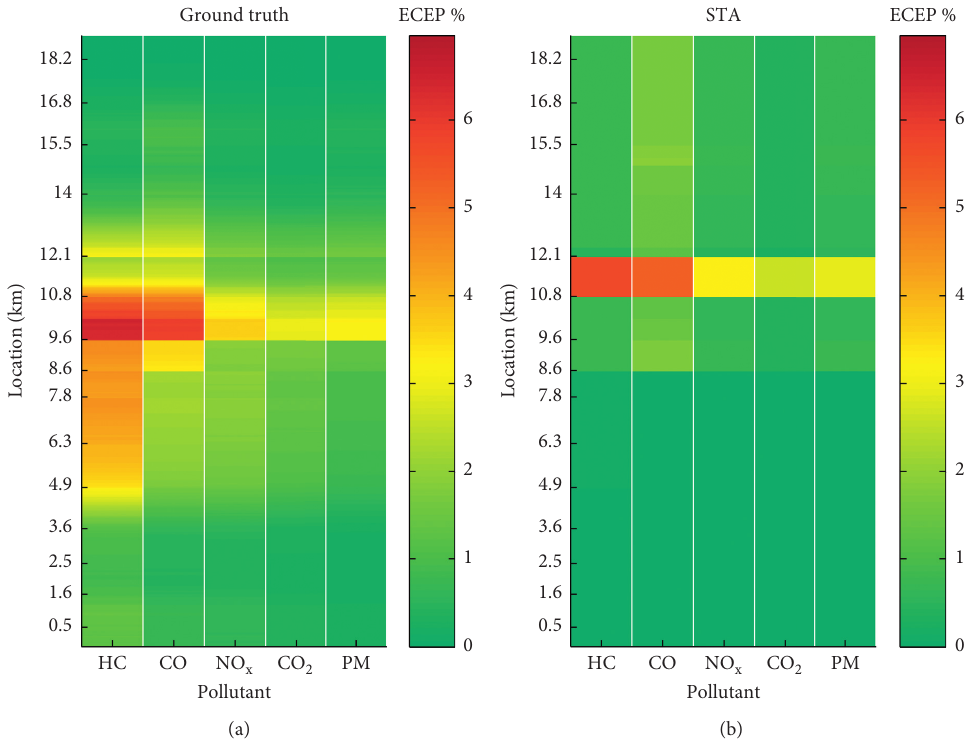
Figure 7: Excess due to congestion emissions based on (a) the ground truth and (b) static